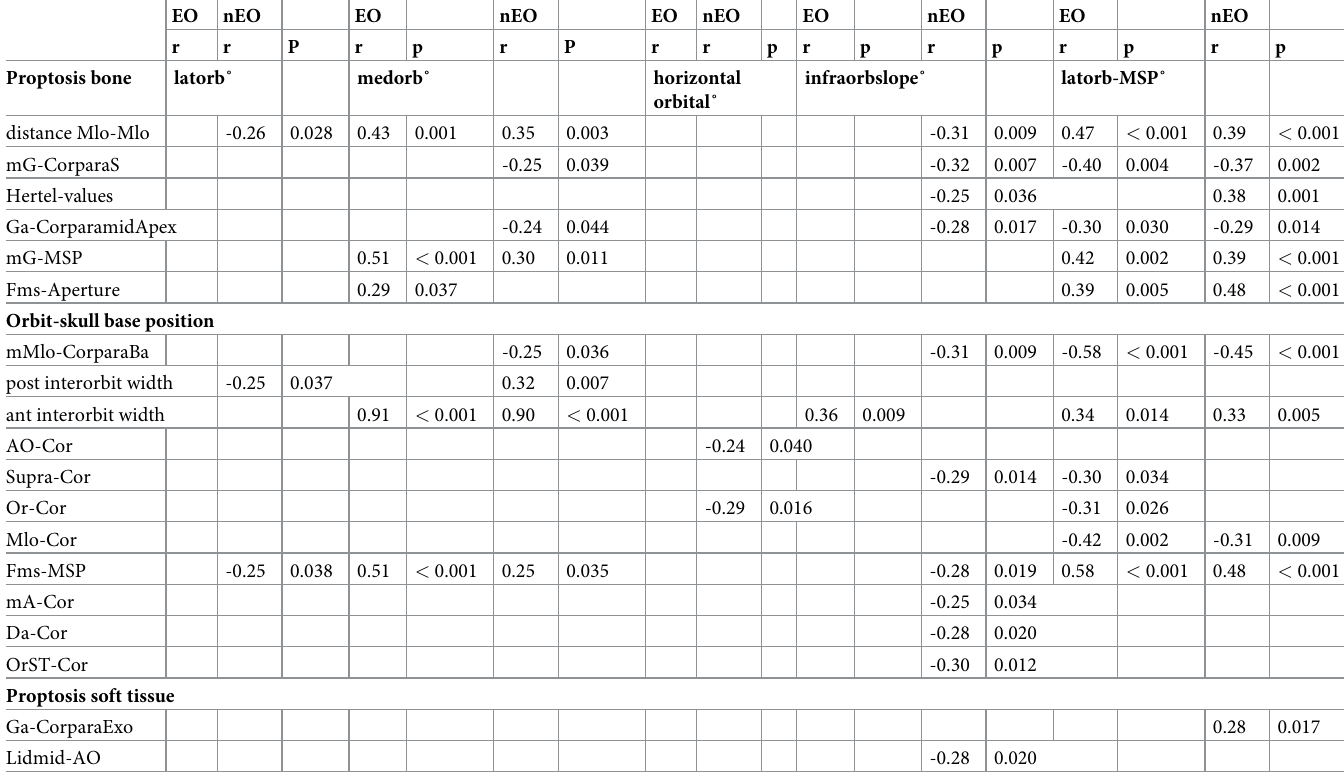
Table 6. Correlations of angle measurements to globe position. Hertel values were defined as: Ga-CorparaMlo and Fms-CorparaGa